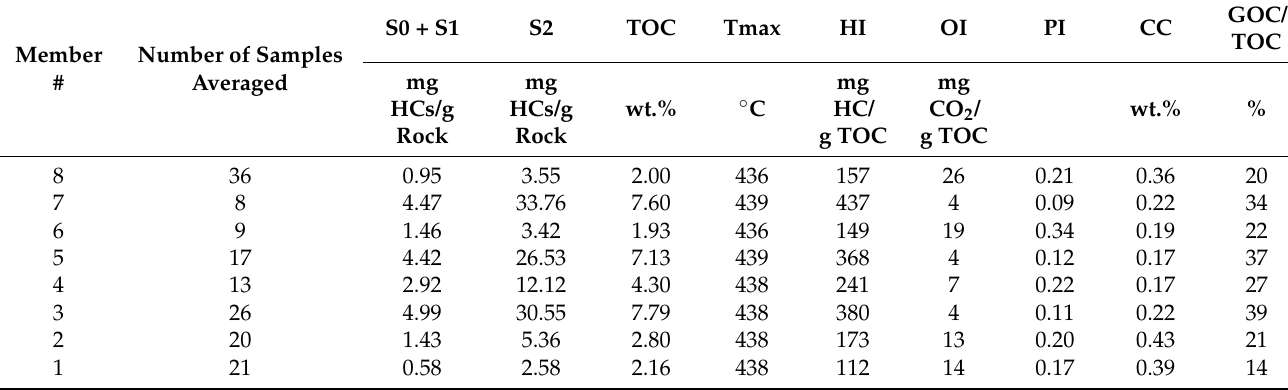
Table A3. Averaged pyrolysis parameters for 8